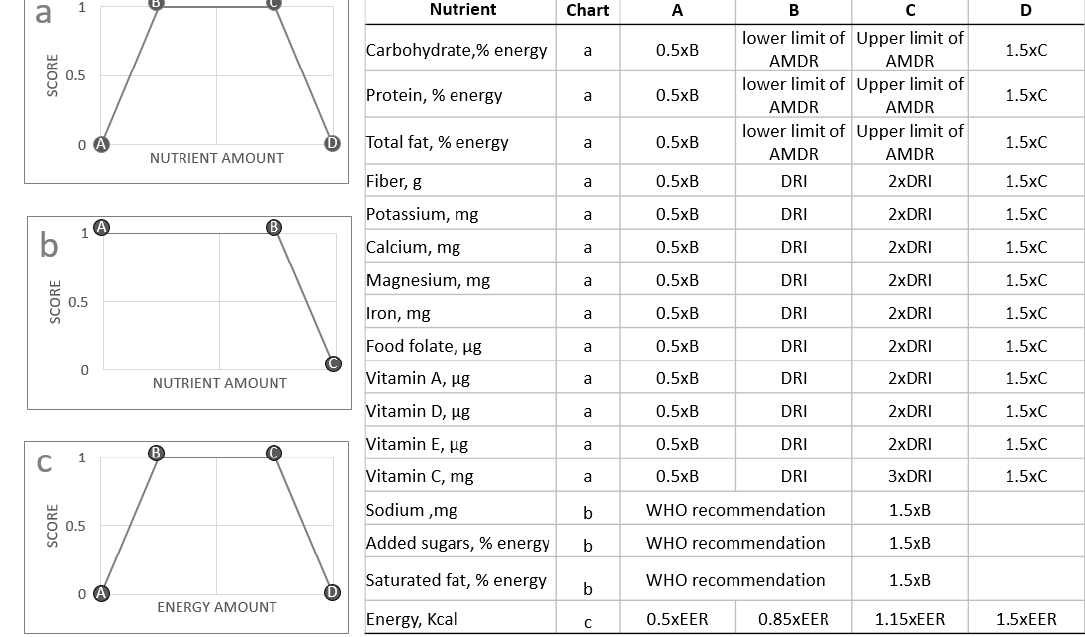
Figure 1. The Nestlé Nutrition Algorithm scoring system. AMDR: Acceptable Macronutrient Distribution Range, DRI: Dietary Reference Intakes, WHO: World Health Organization, EER: Estimated Energy Requirement.